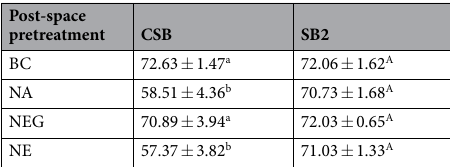
Table 3. Conversion degree values (n = 5; %; mean ± standard deviation). For each vertical column, means with the same superscript letter are not significantly by Tukey test ( P >